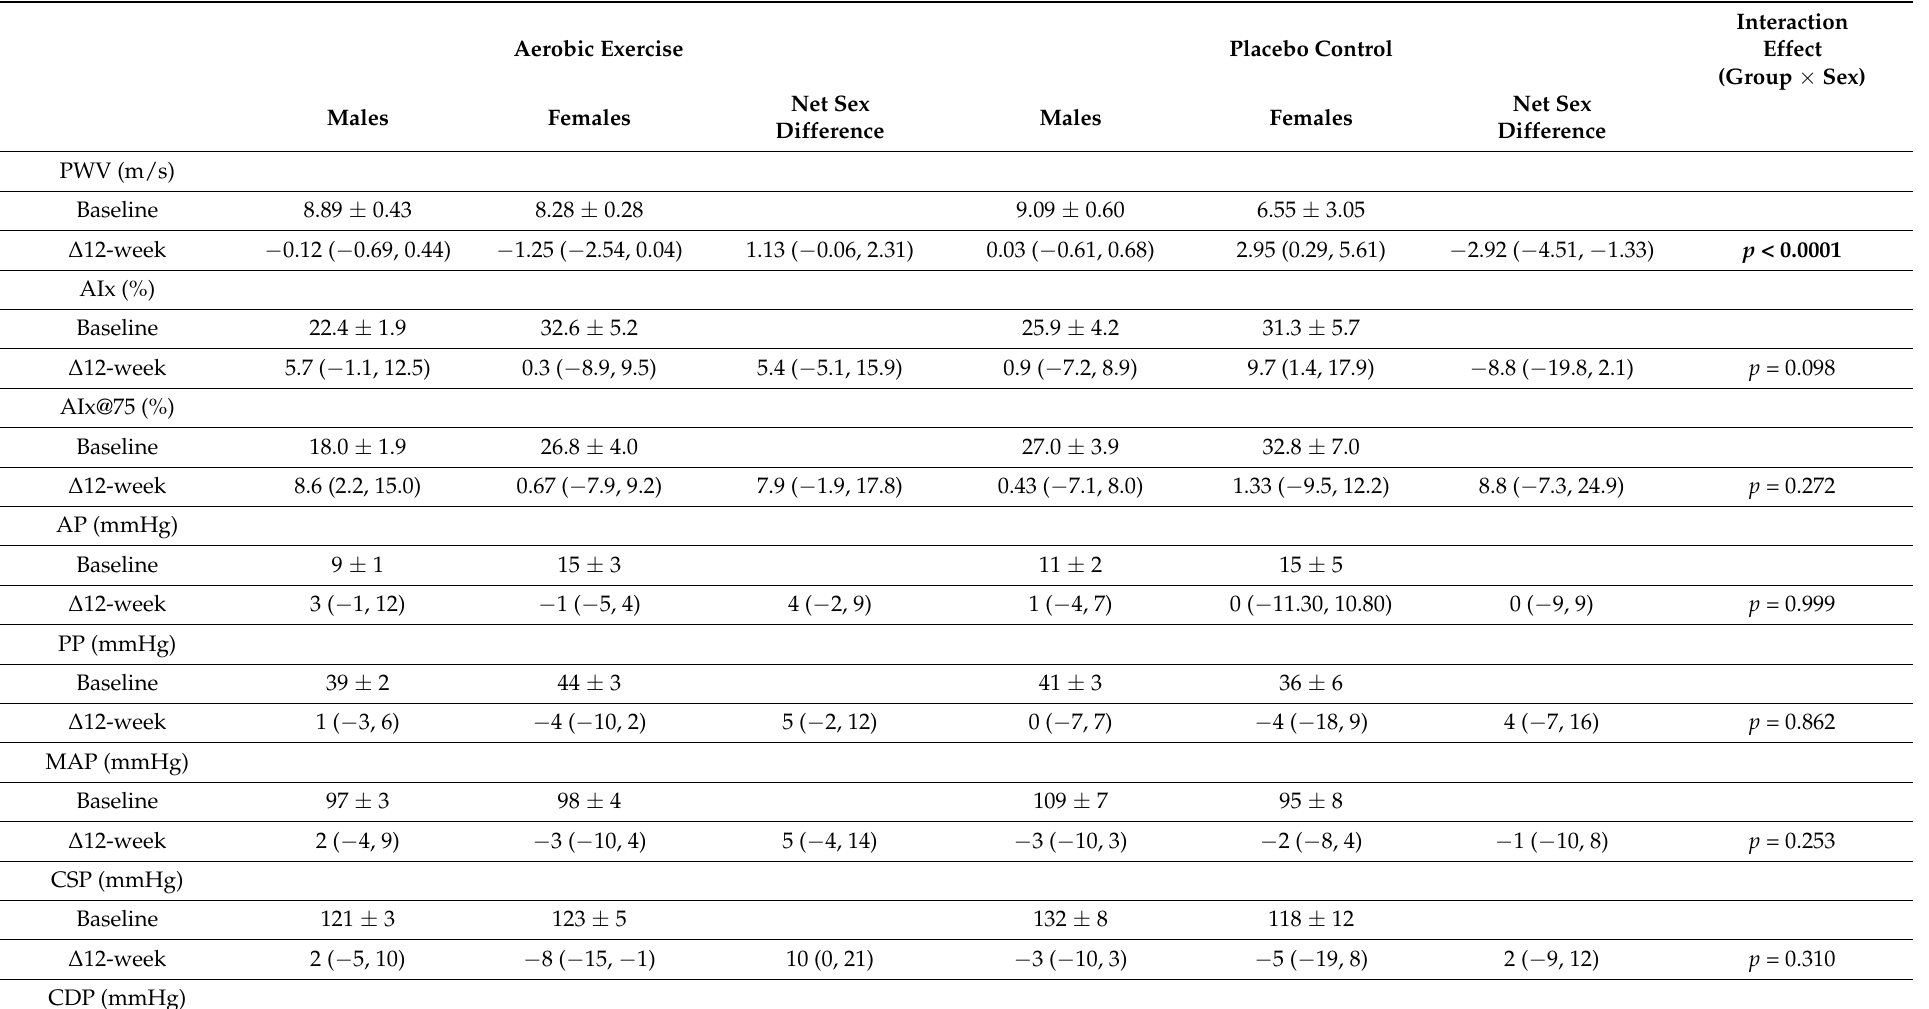
Table 3. Mean baseline arterial health outcomes, within-group changes relative to baseline, and net sex differences per intervention. Aerobic Exercise Placebo Control